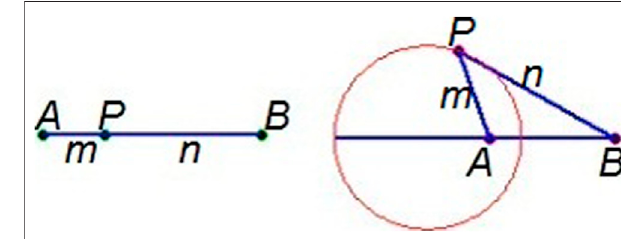
FIGURE 1 | Apollonius circle.